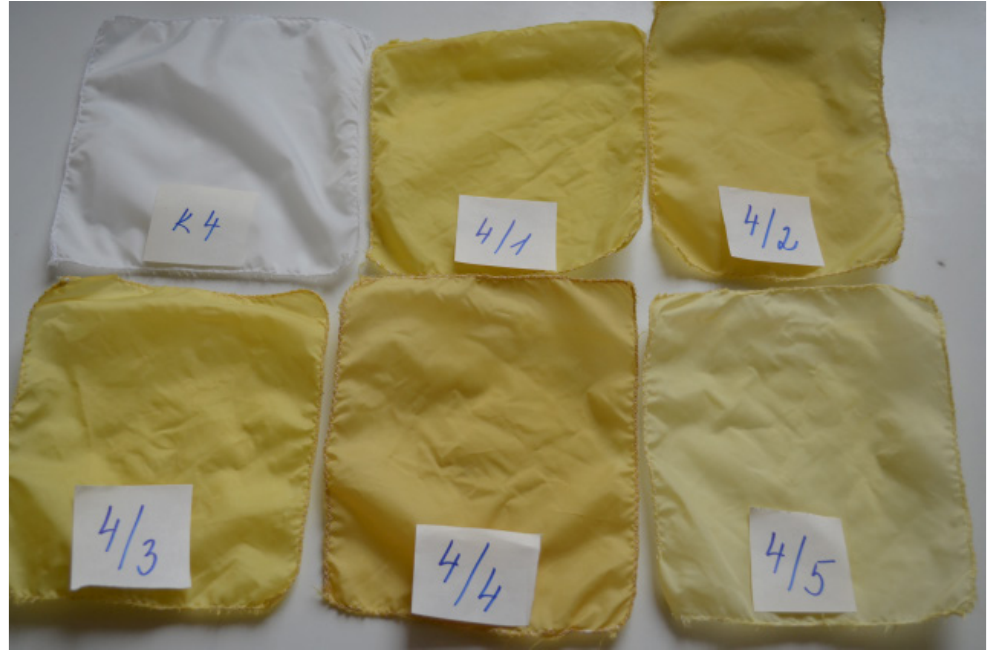
Figure 1 : Colours of ortalion samples (K4 – control, 4/1 Slow infusion of fresh orange Tagetes flowers, 4/2 Slow infusion of fresh orange- brown Tagetes flowers, 4/3 Short infusion of fresh Tagetes flowers mix of both colours, 4/4 Short infusion of dry Tagetes flowers, 4/5 Short infusion of dry Tanacetum